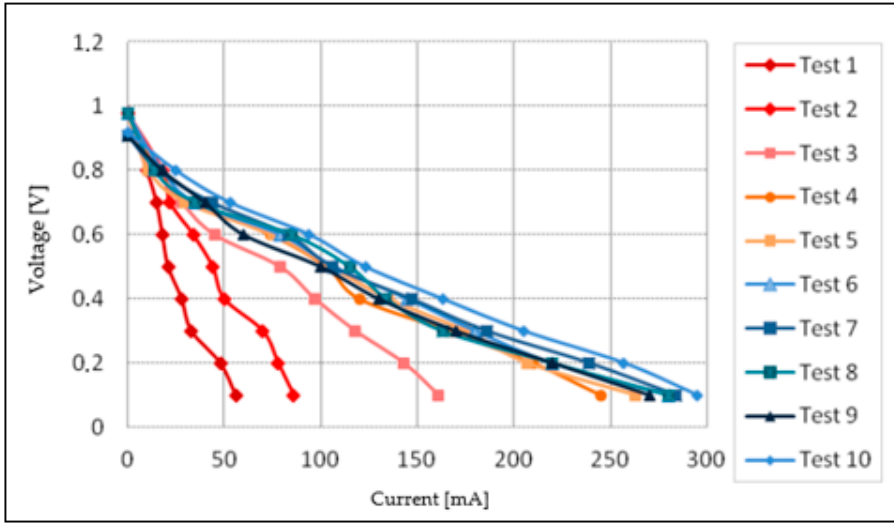
Figure 7. V-I polarization curves of the PEMFC, for different states.